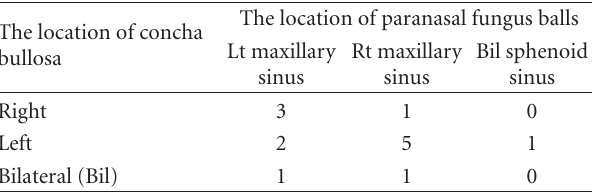
Table 2: The location of concha bullosa and the location of paranasal fungus